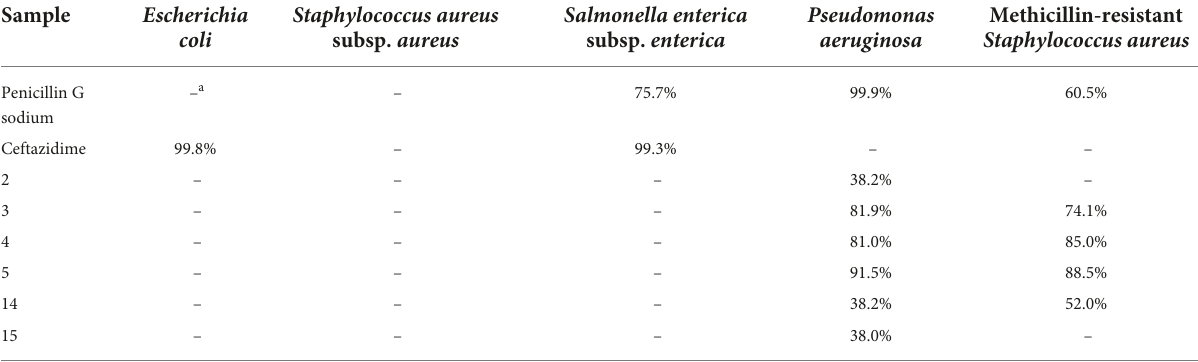
TABLE 4 Inhibition rates of anthraquinone derivatives against the bacteria at the concentration of 200 µ M.